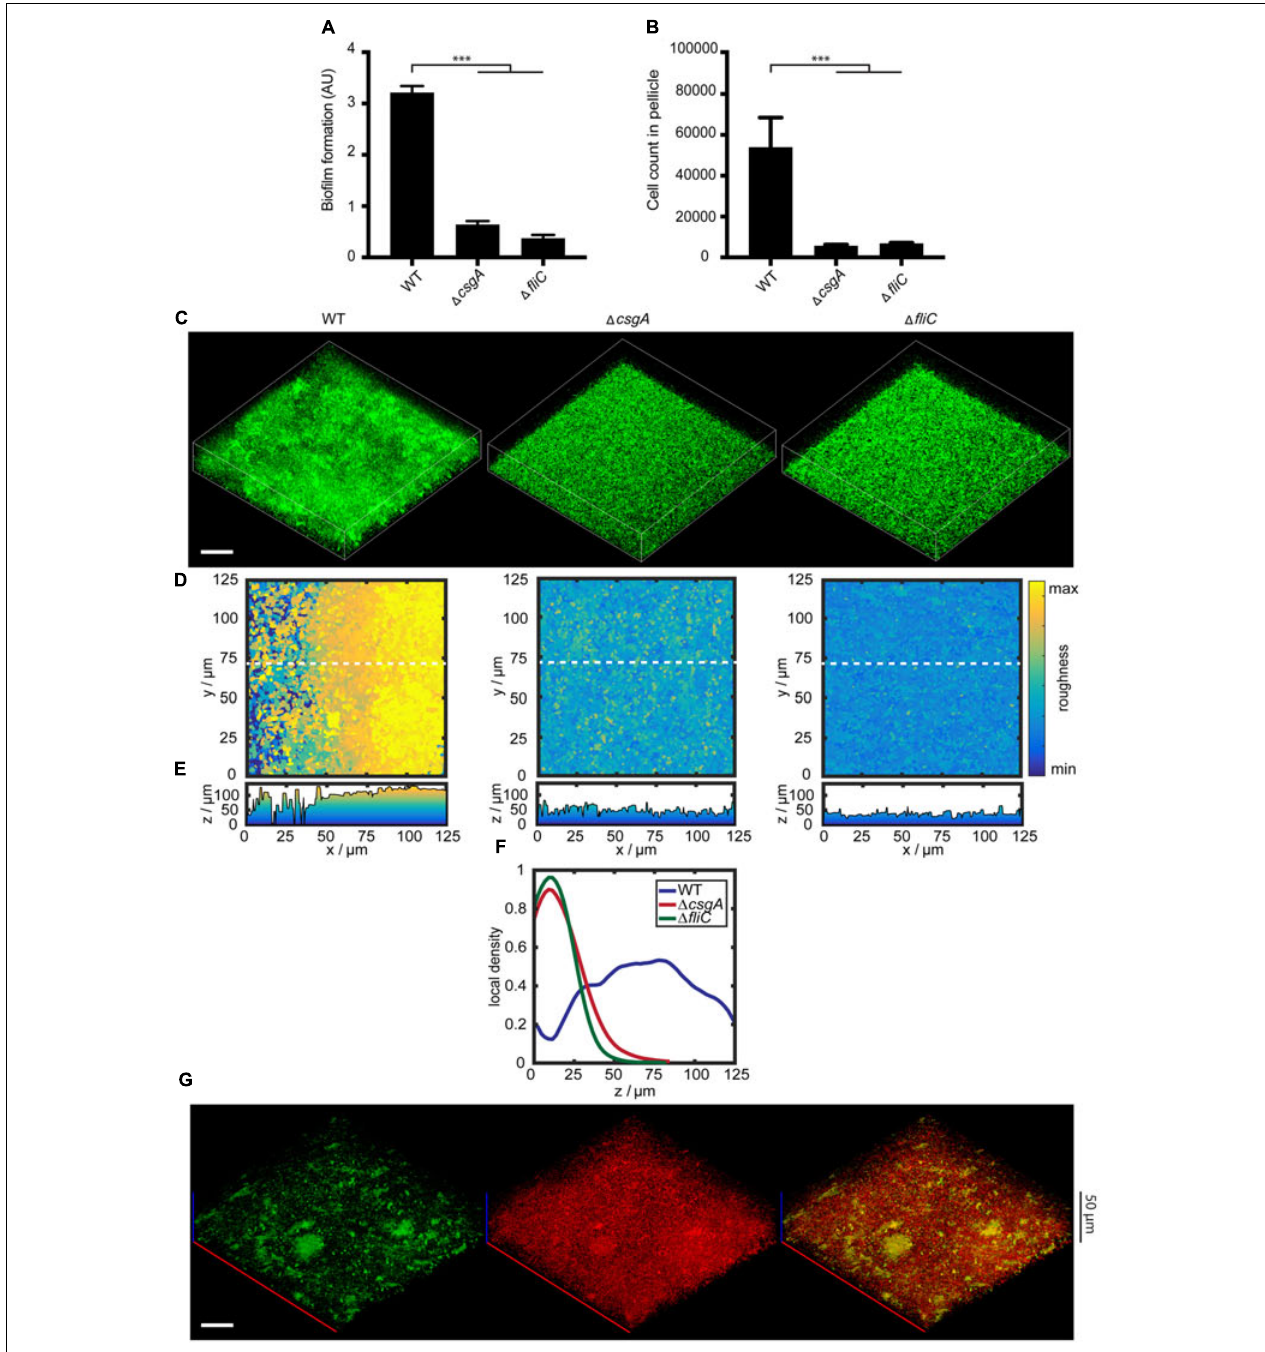
FIGURE 8 | Curli and flagella are required for biofilm structure development in de-domesticated strain AR3110. (A) Biofilm formation by wild-type strain AR3110 and mutants lacking either curli ( (cid:49) csgA ) or flagella ( (cid:49) fliC ) that were grown under static conditions at 30 ◦ C for 24 h. Biofilm formation was quantified using CV staining, with CV values normalized to the optical density shown in arbitrary units (AU). ∗∗∗ indicates P < 0.0001 according to unpaired t -test. Standard errors from three independent experiments are indicated. (B) Number of cells counted per 60 s in the pellicle fraction of submerged biofilms, measured using flow cytometry. (C) Confocal fluorescence microscopy images (maximum projection) of static biofilms grown in microtiter plates at 30 ◦ C for 24 h. All cells were labeled with eGFP as in Figure 1D . Scale bar, 40 µ m. (D) Top views and corresponding (E) roughness profiles of submerged biofilms shown in (C) . The color scale shows roughness values from lowest (blue) to highest (yellow). (F) The profiles of mean local density throughout the biofilm height ( z -axis) are shown in blue for W3110 (WT), in green for the mutant lacking flagella ( (cid:49) fliC ) and in red for the mutant lacking curli ( (cid:49) csgA ). (G) Confocal images (maximum projection) showing expression of P csgA -sfGFP (green) in static biofilms, grown in microtiter plates at 30 ◦ C for 24 h. For a reference, all cells were labeled with constitutively expressed mCherry (red) (pOB2). Scale bar, 40 µ m.